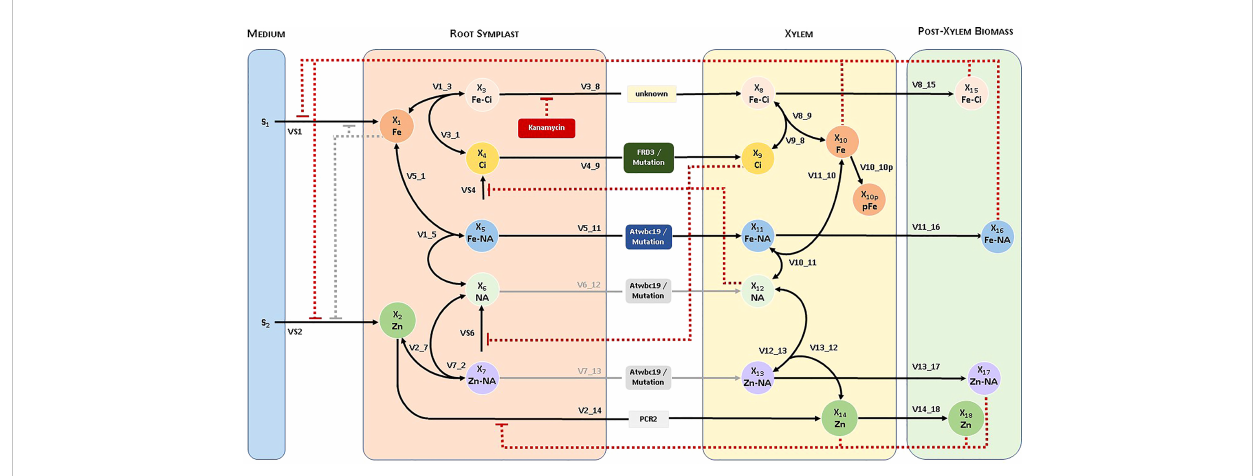
FIGURE 1 Diagram of the pathway system, and naming of variables for the Fe and Zn uptake system in Arabidopsis . The ability of WBC19 to transport Zn-NA or NA is not critical to the model and therefore represented by grey lines. Similarly, initially considered but ultimately unimportant regulatory signals are shown in